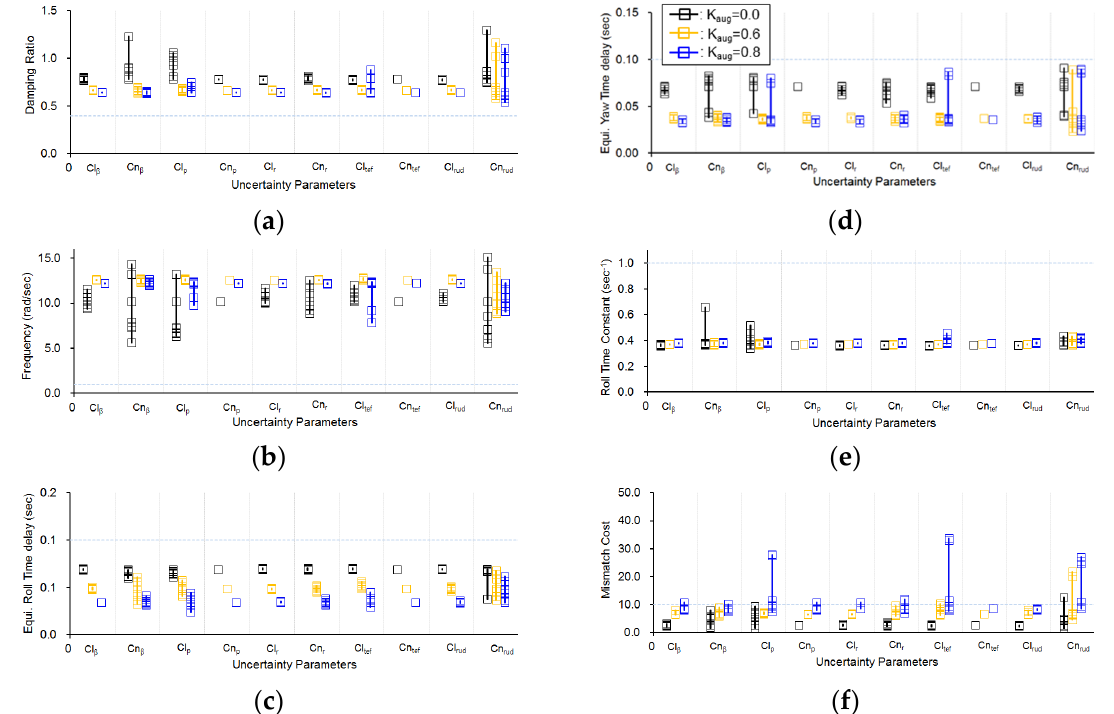
Figure 7. LOES analysis results of the control system on various uncertainties in M0.8, 20 Kft altitude ( a ) short-period damping, ( b ) short-period frequency, ( c ) equivalent roll time delay, ( d ) equivalent yaw time delay, ( e ) roll mode time constant, ( f ) LOES mismatch